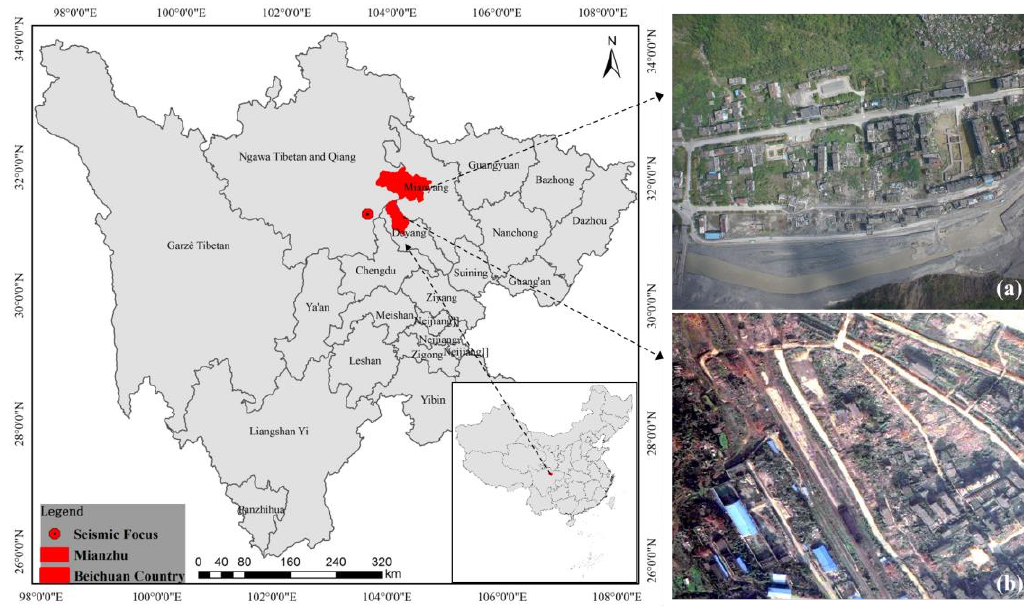
Figure 2 . Location map of study area. ( a ) Beichuan site; ( b ) Hanwang site. Figure 2. Location map of study area. ( a ) Beichuan site; ( b ) Hanwang